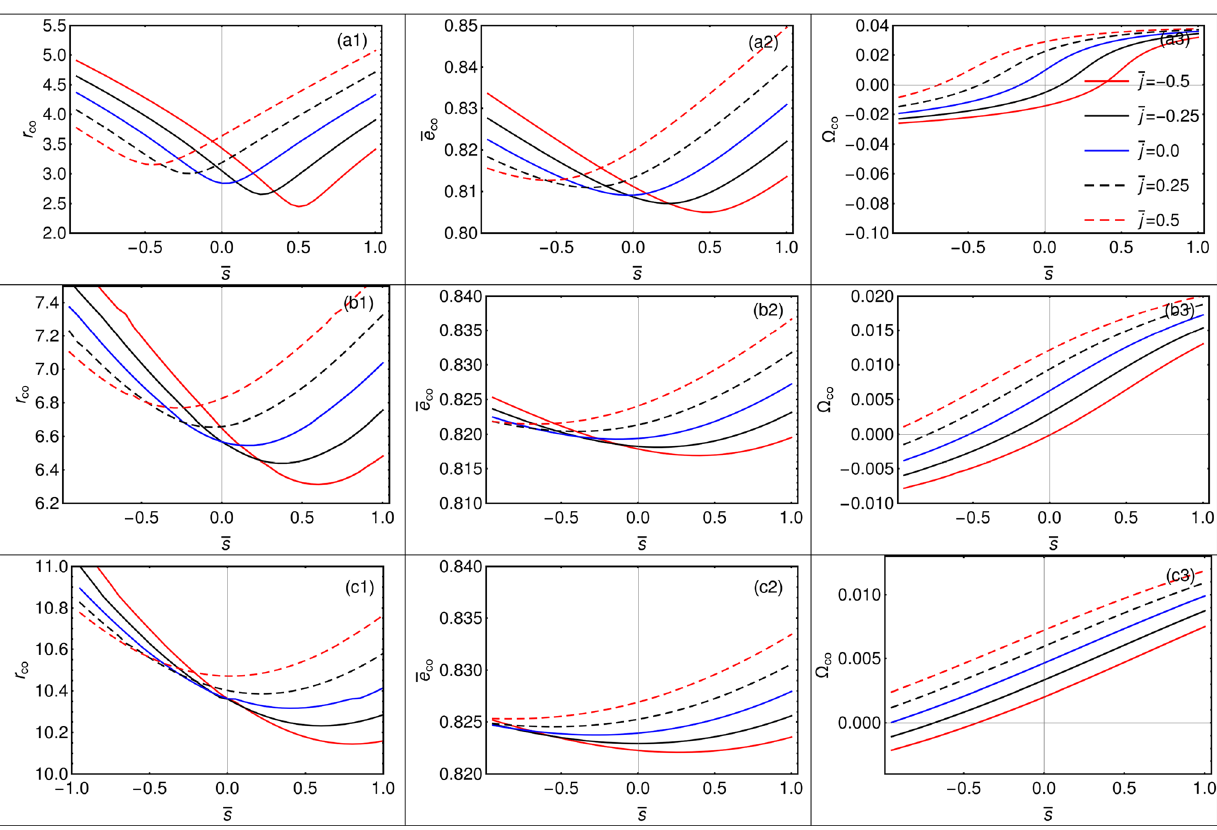
Fig. 2 The relations between the circular orbit parameters and the test particle spin. The parameters ω and k is taken as ω = 0 . 89 and k = ( 1 , 2 , 3 ) for subfigures ( a1 – a3 ), ( b1 – b3 ), ( c1 – c3 ),